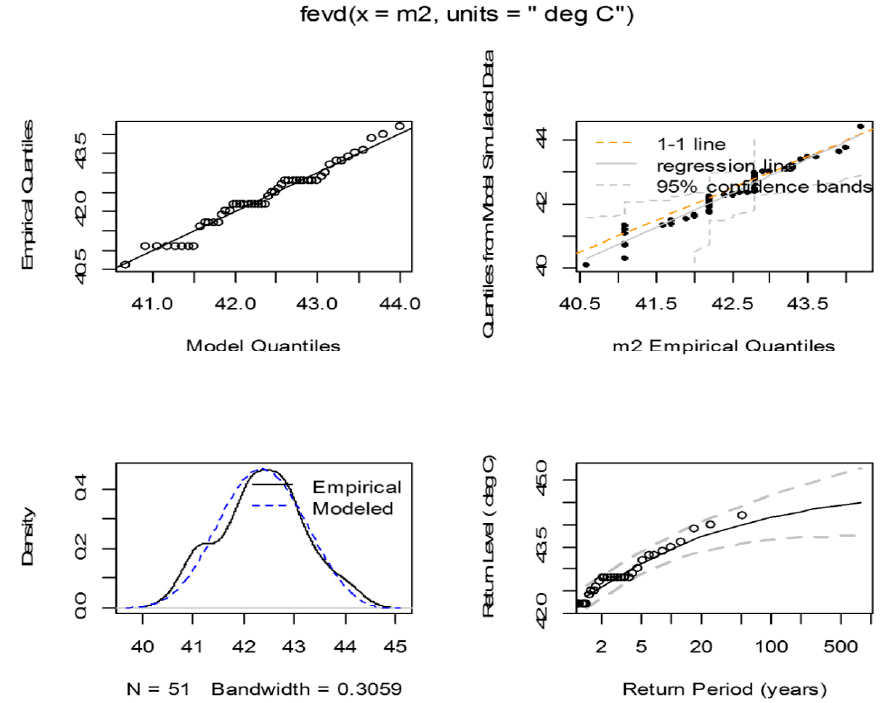
Figure 5. Diagnostic annual maximum temperature plots.